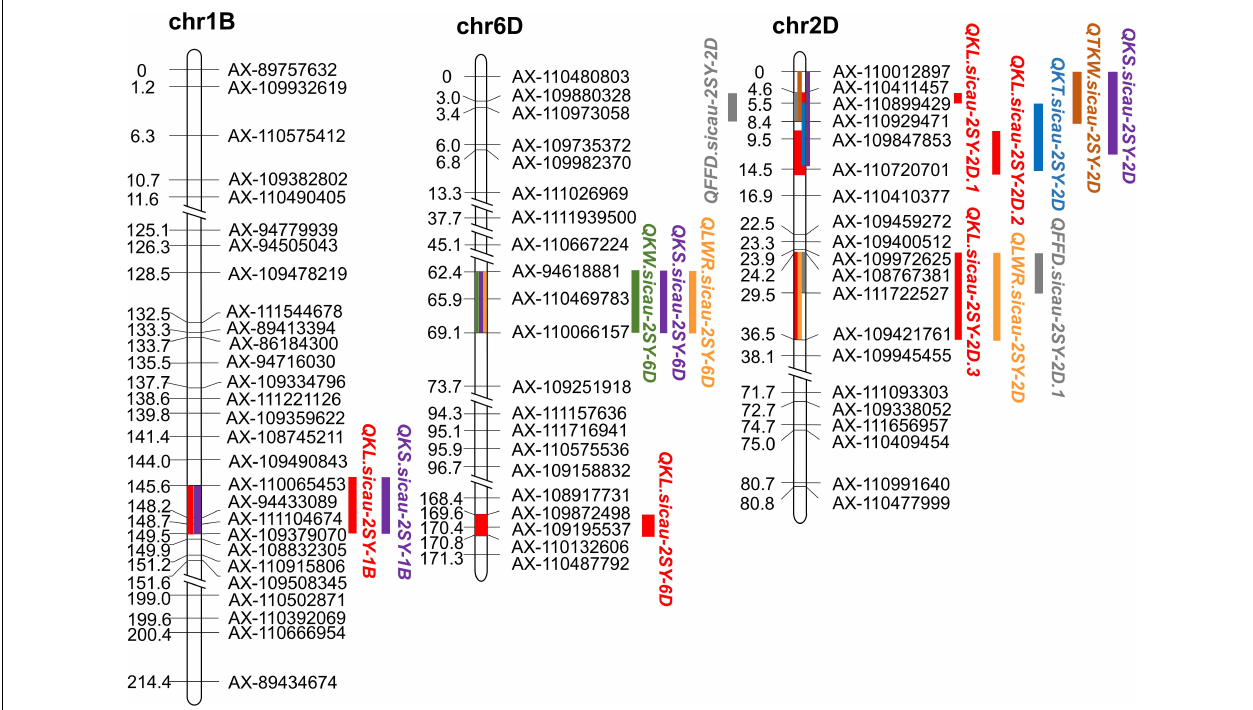
FIGURE 3 | Fifteen major or minor QTLs for kernel traits in the genetic map. Red color represents QTL conferring kernel length (KL), green color represents QTL conferring kernel width (KW), blue color represents QTL conferring kernel thickness (KT), brown color represents QTL conferring thousand-kernel weight (TKW), orange color represents QTL conferring kernel length–width ratio (TKW), purple color represents QTL conferring kernel size (KS), and gray color represents QTL conferring factor form density